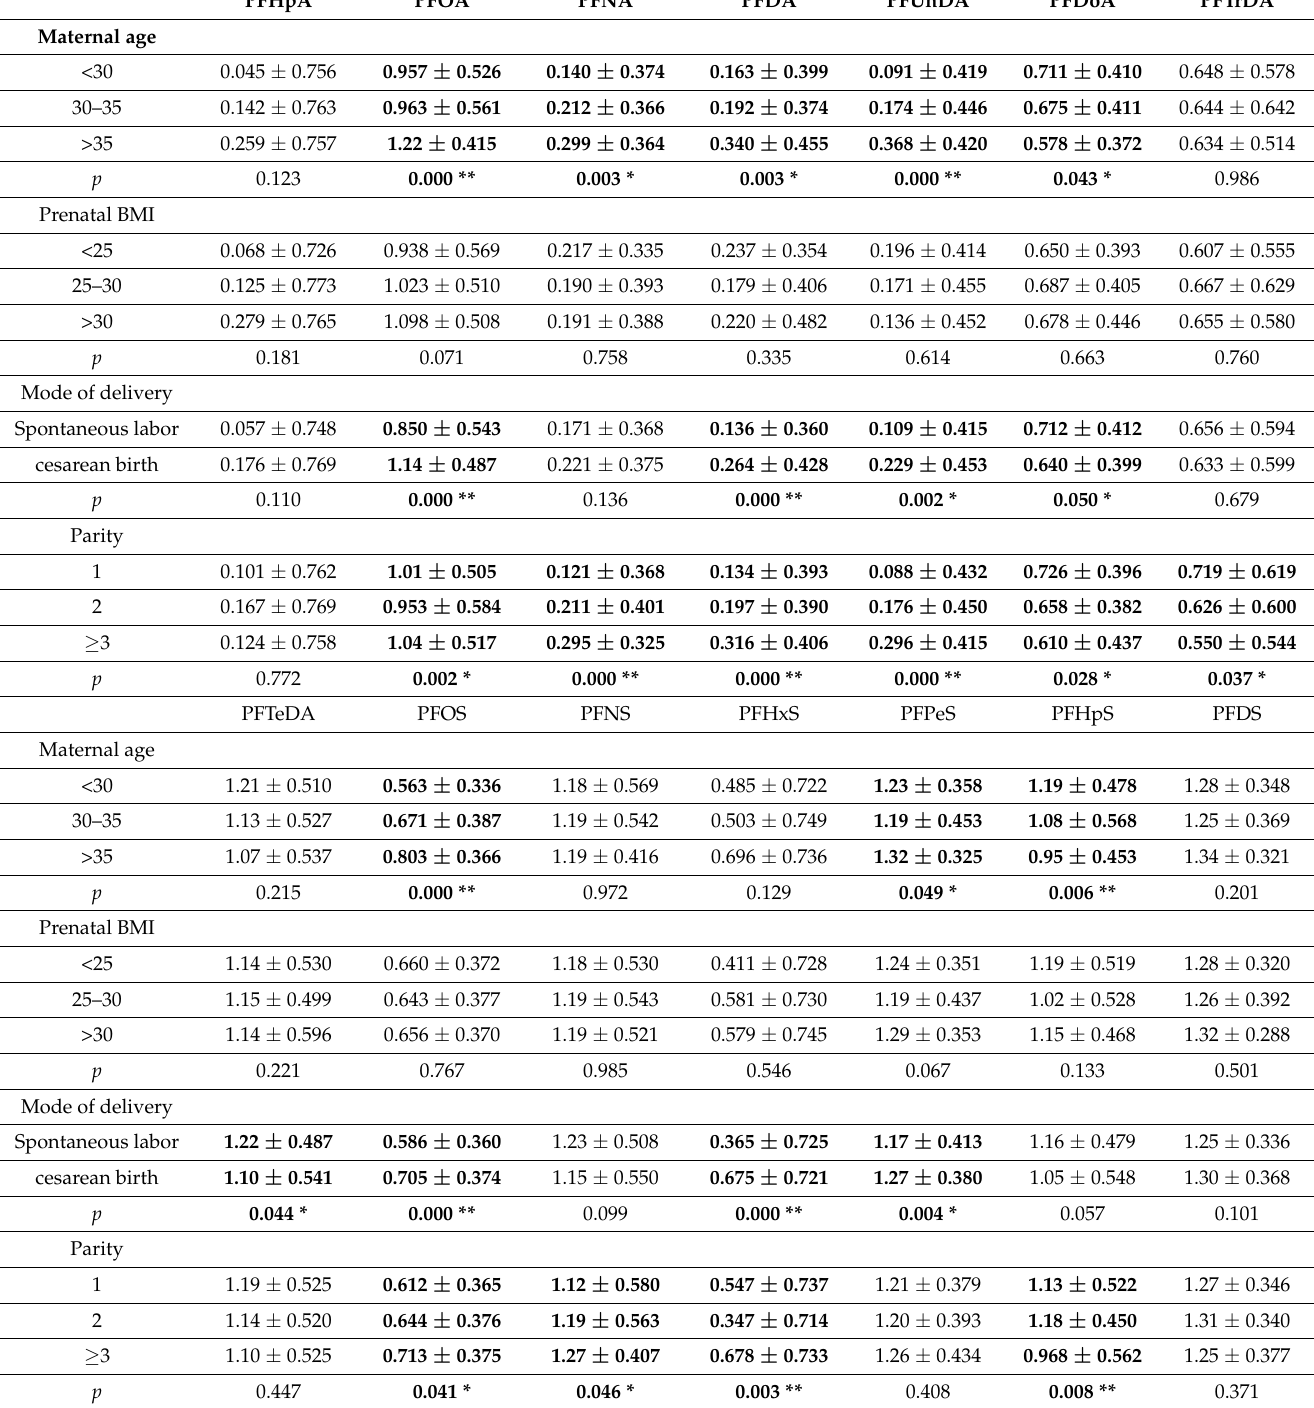
Table 1. Effect of different demographic characteristics on the distribution of PFASs (ng/mL) in maternal serum (Mean ±